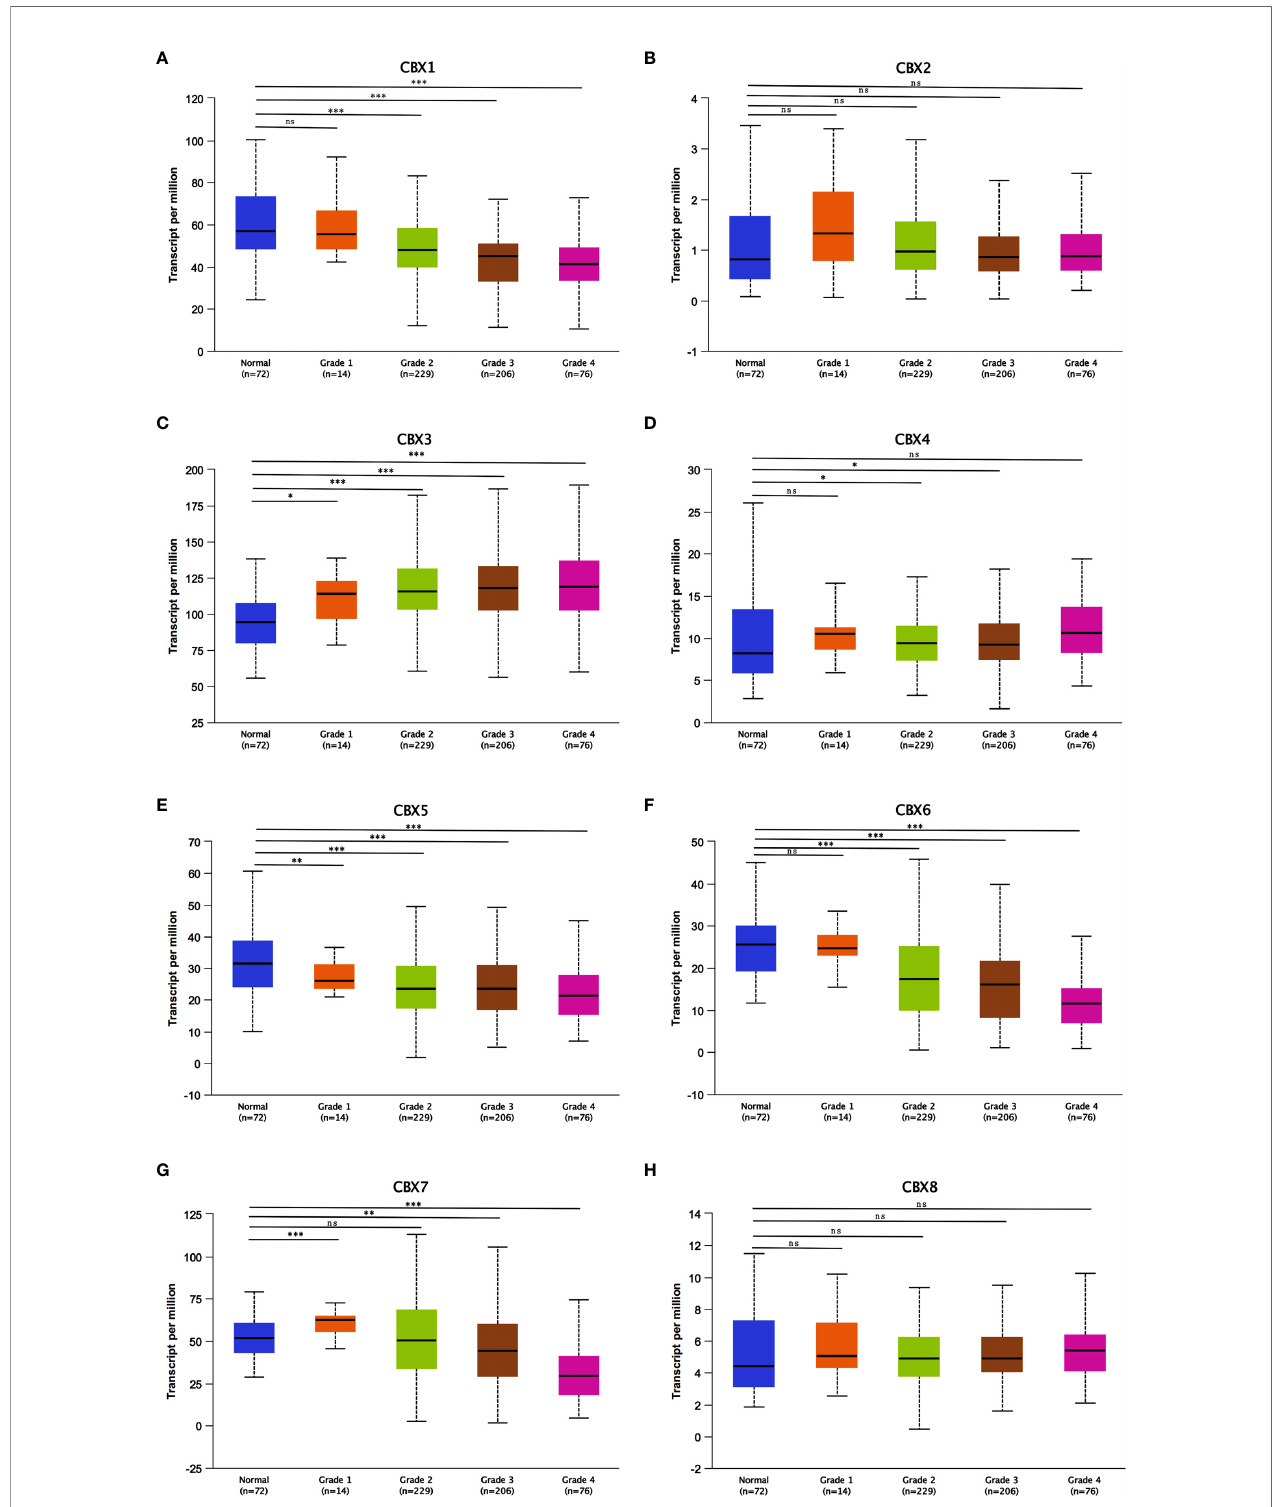
FIGURE 8 | Association of mRNA expression of CBXs with tumor grades of ccRCC patients (UALCAN). ccRCC patients who were in more advanced tumor grades tended to express higher mRNA expression of CBX3 and CBX4 (C, D) , while lower mRNA expression of CBX1, CBX5, CBX6 and CBX7 (A, E – G) . CBX2 and CBX8 did not signi fi cantly differ in tumor grades (B, H) . (* P <0.05, ** P <0.01, *** P <0.001, ns: no signi fi